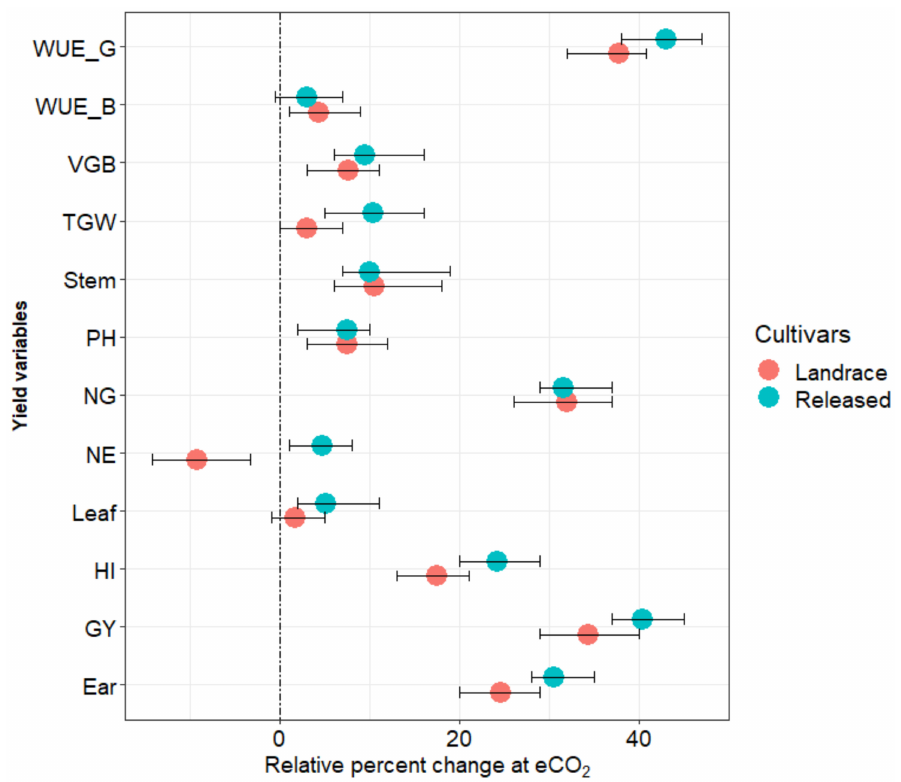
Figure 1. Relative effect of eCO 2 condition on plant height, biomass fractions, yield components, and water-use efficiency of barley. Average relative changes due to CO 2 enrichment against aCO 2 are presented, with error bars representing their standard errors. Ear: ear biomass; GY: grain weight; HI: harvest index; Leaf: leaf biomass; NE: number of ears; NG: grain number; PH: plant height; Stem: stem biomass; TGW: thousand-grain weight; VGB: vegetative biomass; WUE_B: water-use efficiency of vegetative biomass; and WUE_G: water-use efficiency of